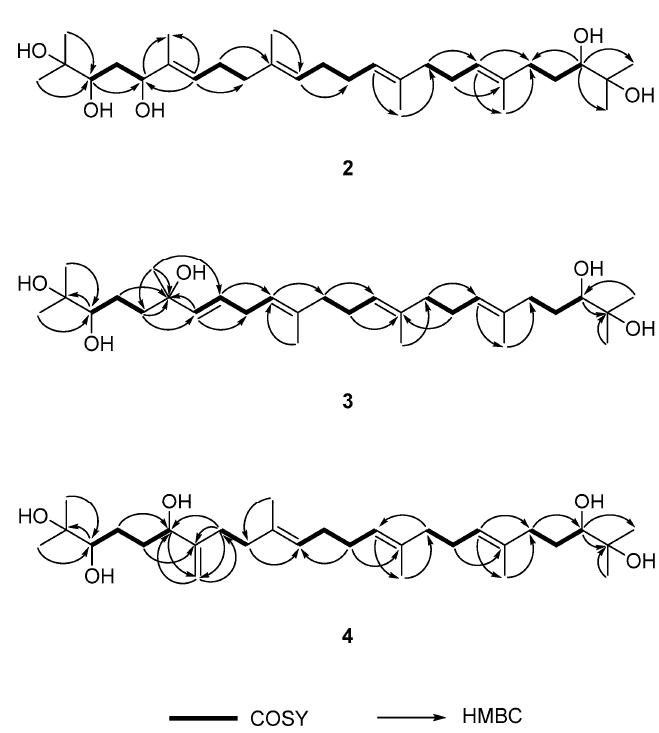
Figure 2. Key COSY and HBMC correlations of Compounds 2 – 4 .